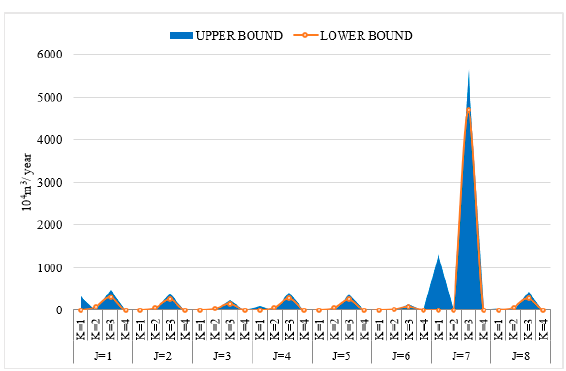
Figure 15. Water reuse in water use departments under the medium level of available water resources.